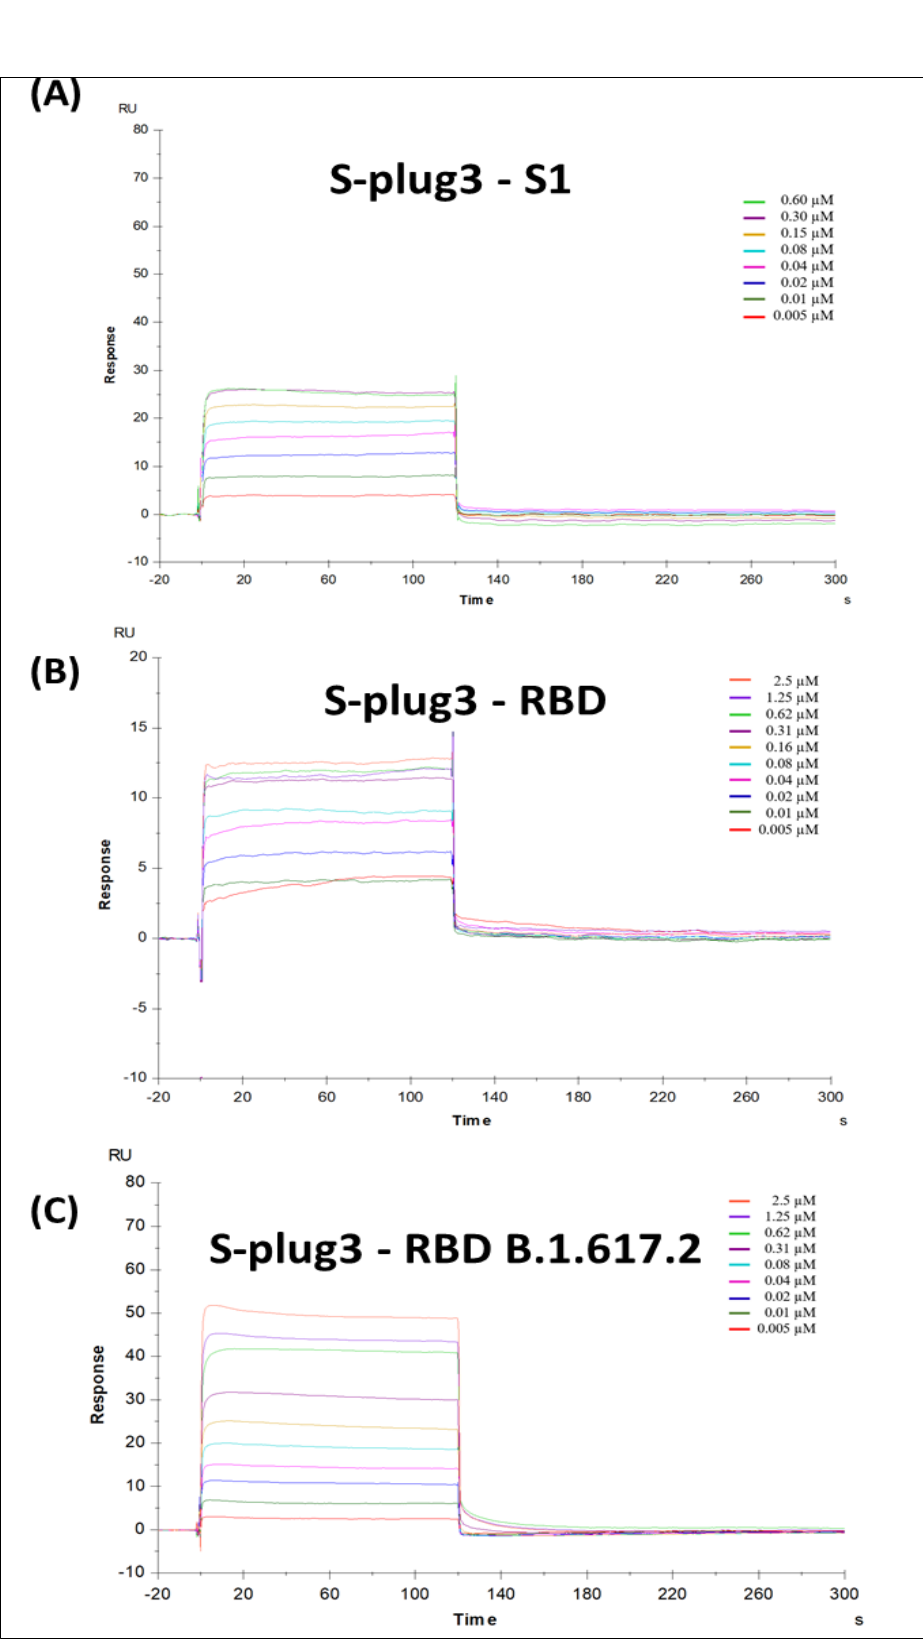
Figure 5. Surface plasmon resonance (SPR) analysis. Sensorgrams to evaluate the binding affinity between S-plug3 and ( A ) spike S1 domain, ( B ) spike RBD, ( C ) spike RBD B.1.617.2 (delta) variant.